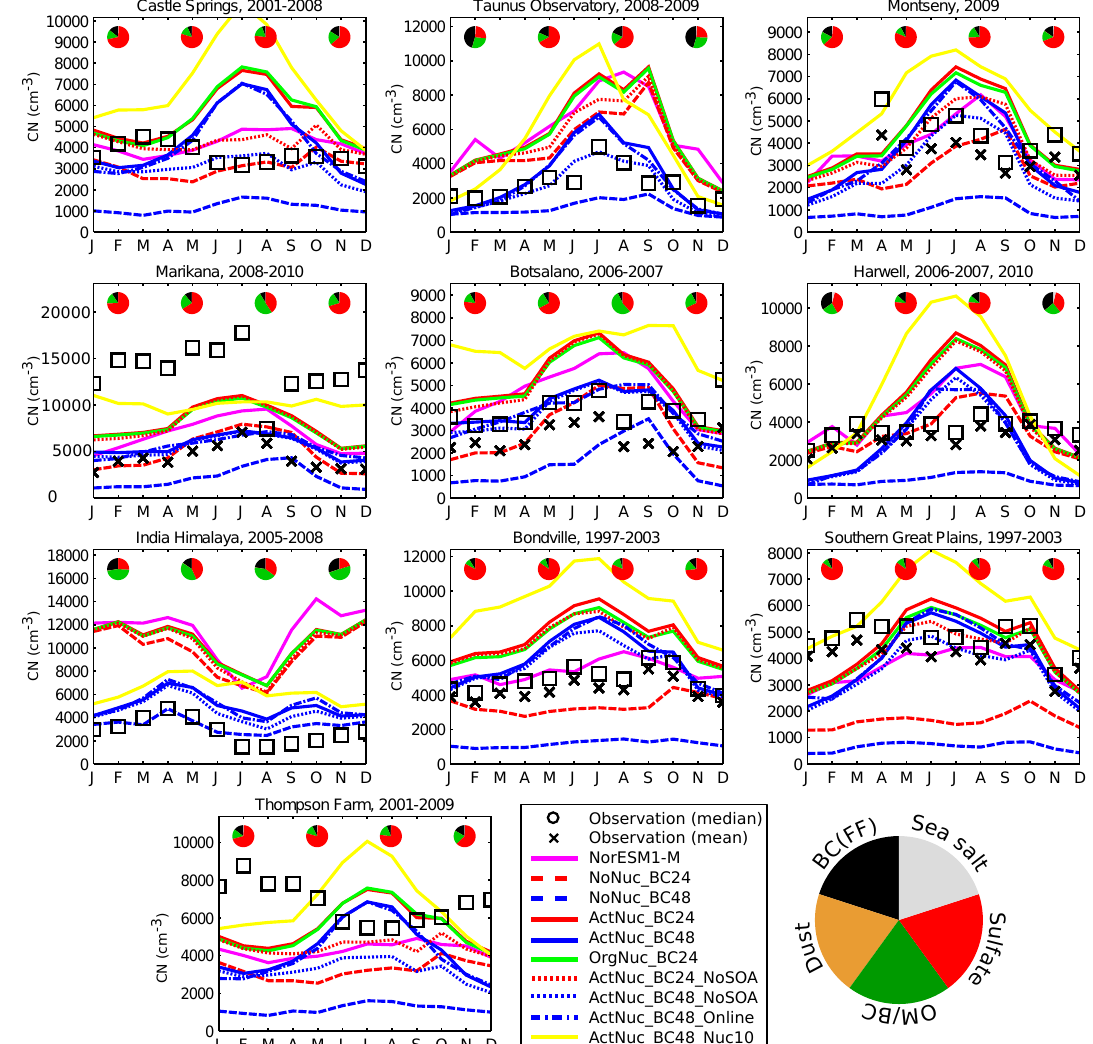
Figure 11. As Fig. 5, but for rural sites (continued from Fig.